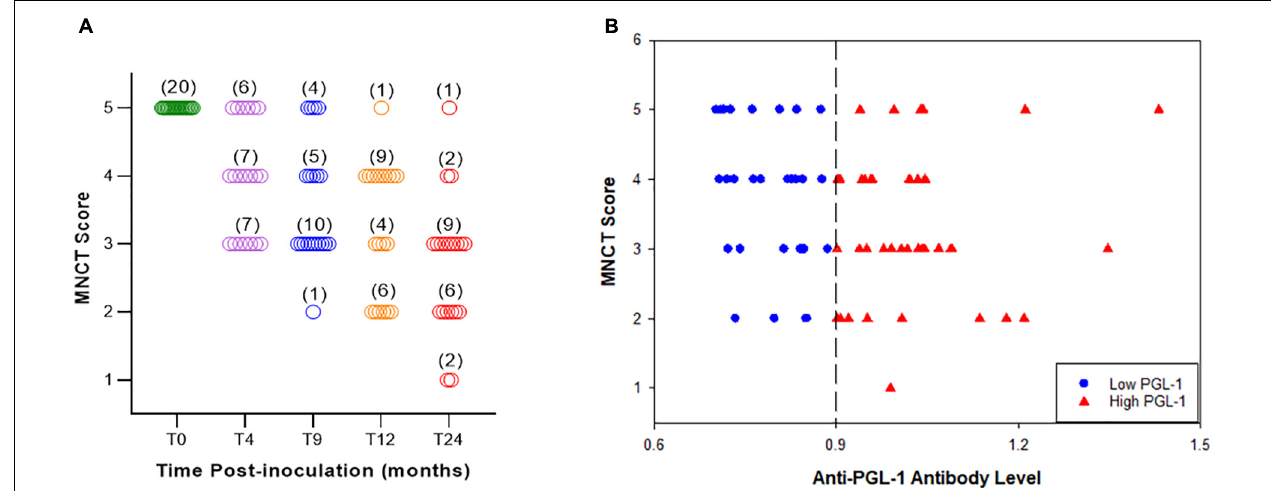
FIGURE 4 | MNCT scores decrease with duration of infection and correlate with anti-PGL1 antibody titers. A longitudinal study (A) demonstrated negative correlation between the MNCT score and duration of M. leprae infection, indicating progressive nerve injury ( N = 20). (B) Phenolic glycolipid I (PGL-1) antigen was